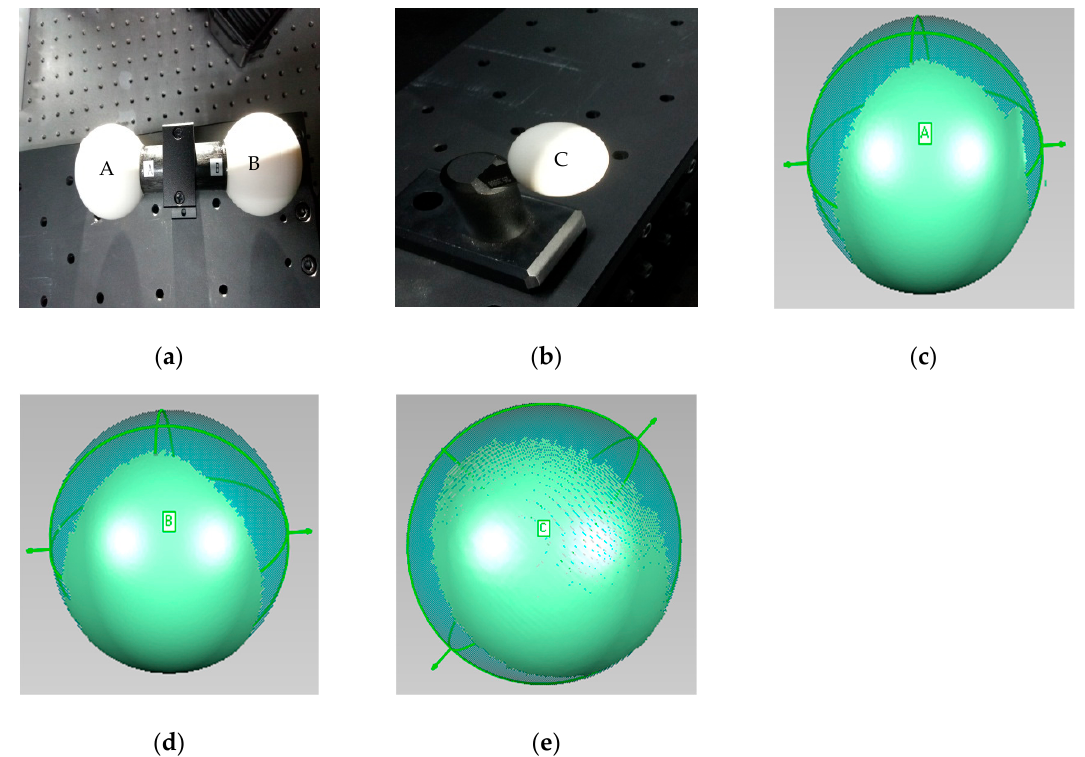
Figure 8. Standard calibration balls. ( a ) A and B balls, ( b ) C ball, ( c ) point cloud of A, ( d ) point cloud of B, ( e ) point cloud of C.